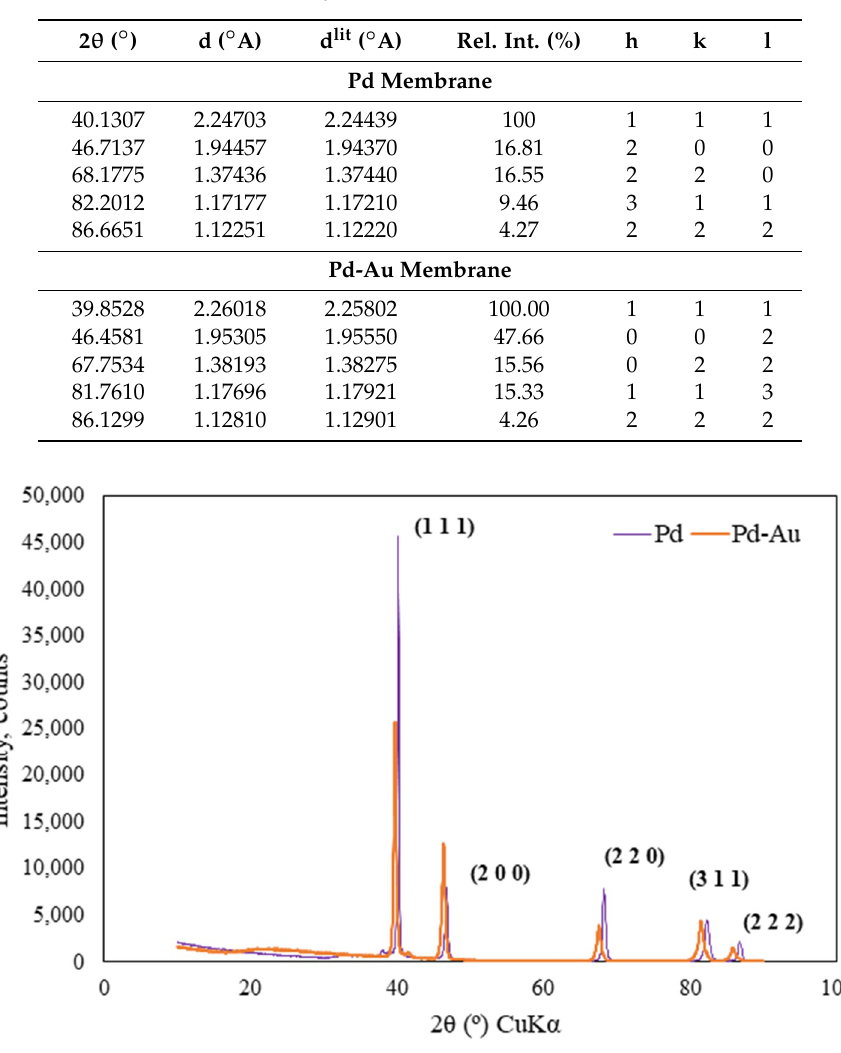
Figure 15. XRD analysis of Pd/YSZ and Pd membranes after the permeation tests.